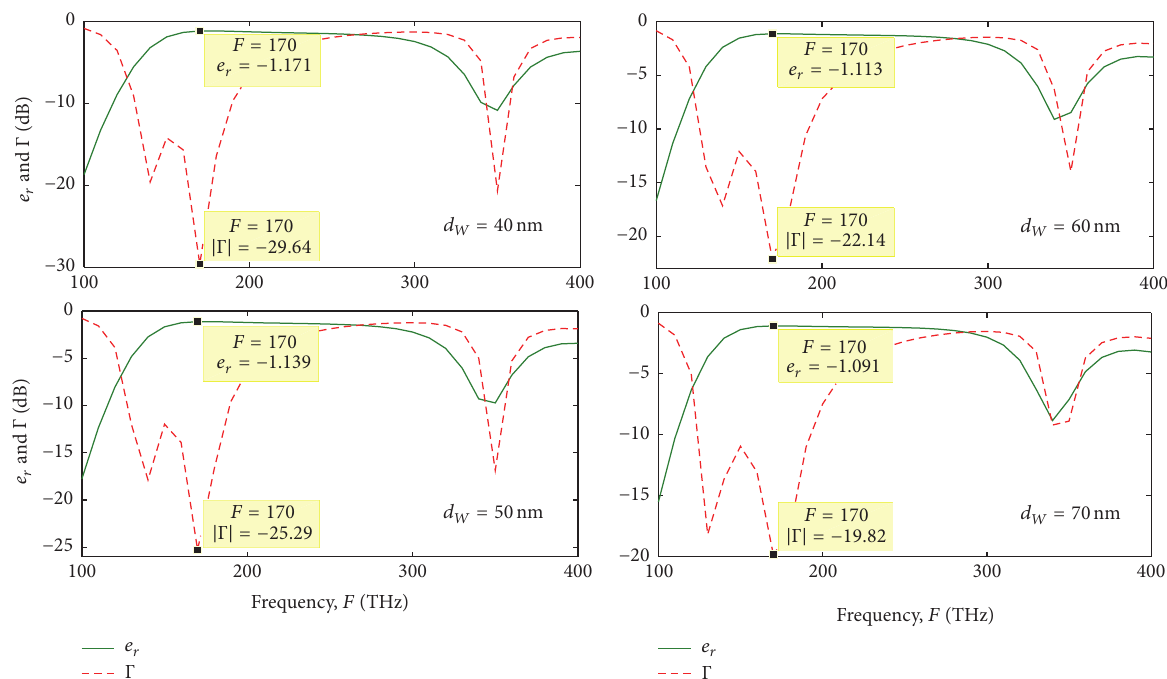
Figure 13: Radiation efficiency ( 𝑒 𝑟 ) and reflection coefficient ( Γ ) of the composed nanoantenna as a function of the frequency calculated through Comsol with 𝑑 𝑊 = 40, 50, 60, and 70 nm and 𝑑 𝐻 =